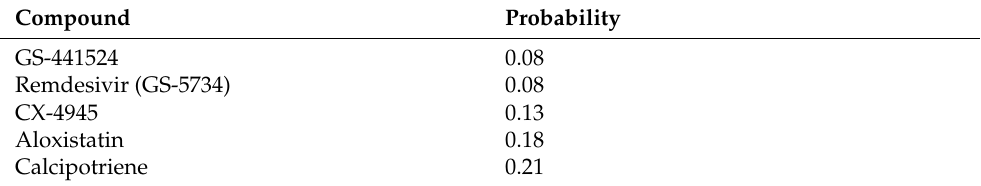
Figure 7. Histograms of probability scores for different compounds. In each plot, for each compound, the horizontal axis is divided in to 7 bins. The vertical axis shows the number of samples in each bin. Table 3. List of compounds with low probability scores (classified as mock).